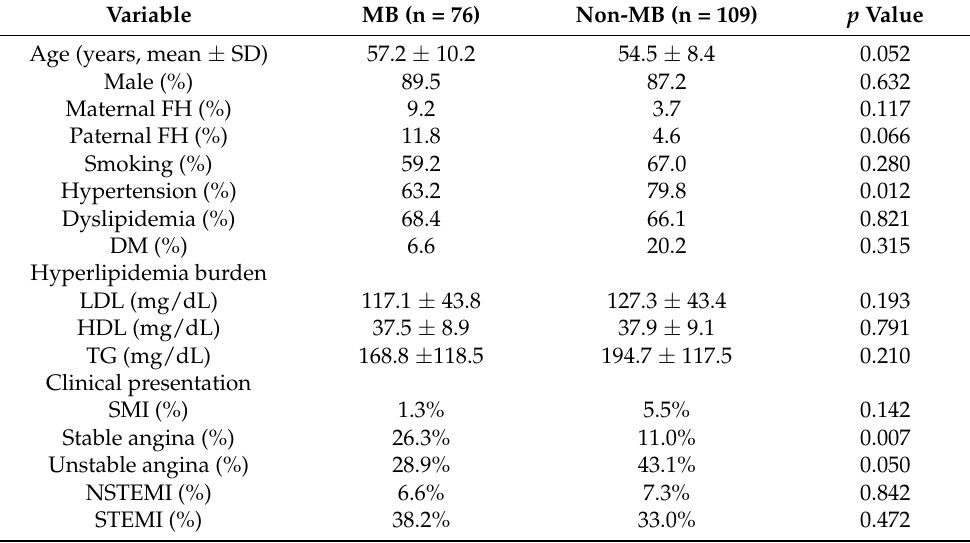
Table 2. Baseline demographic associated cardiovascular risk factors, and clinical characteristics of patients.